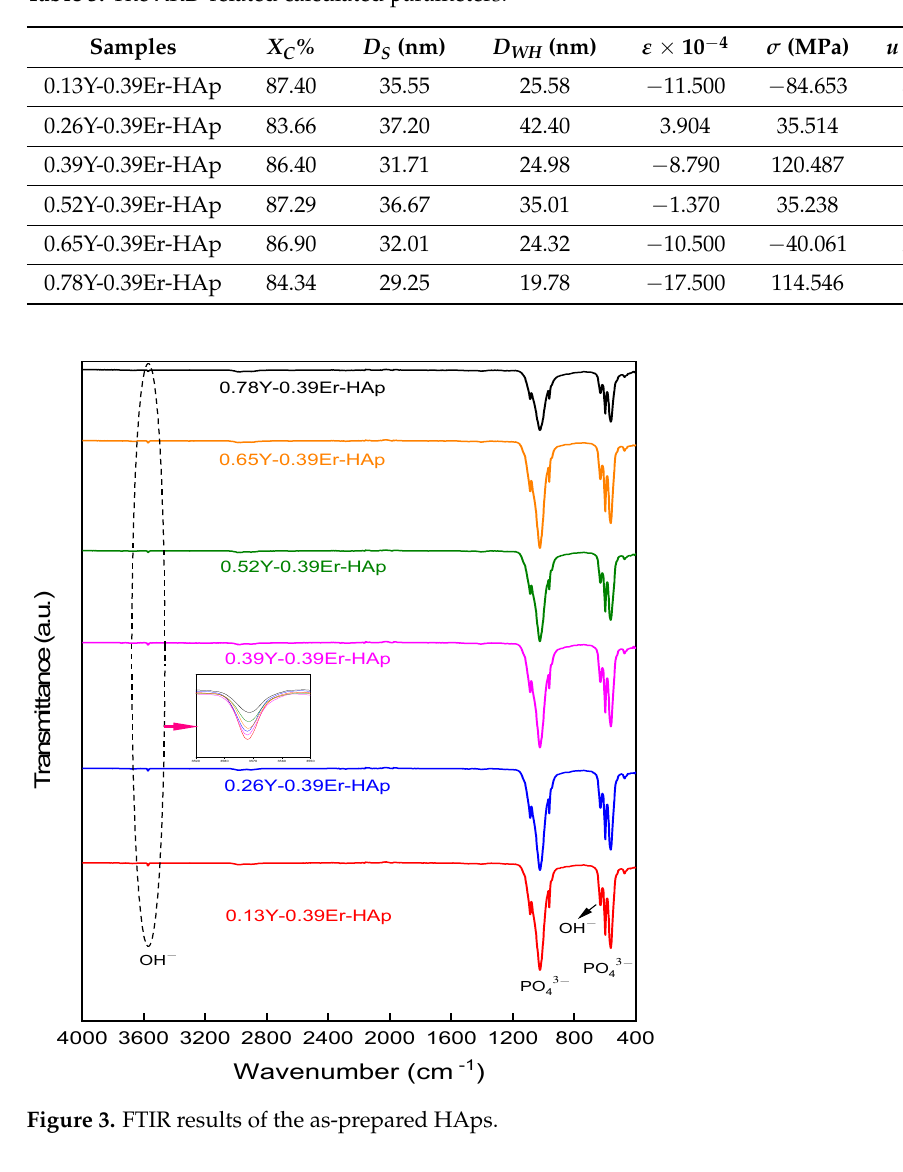
Table 3. The XRD-related calculated parameters.